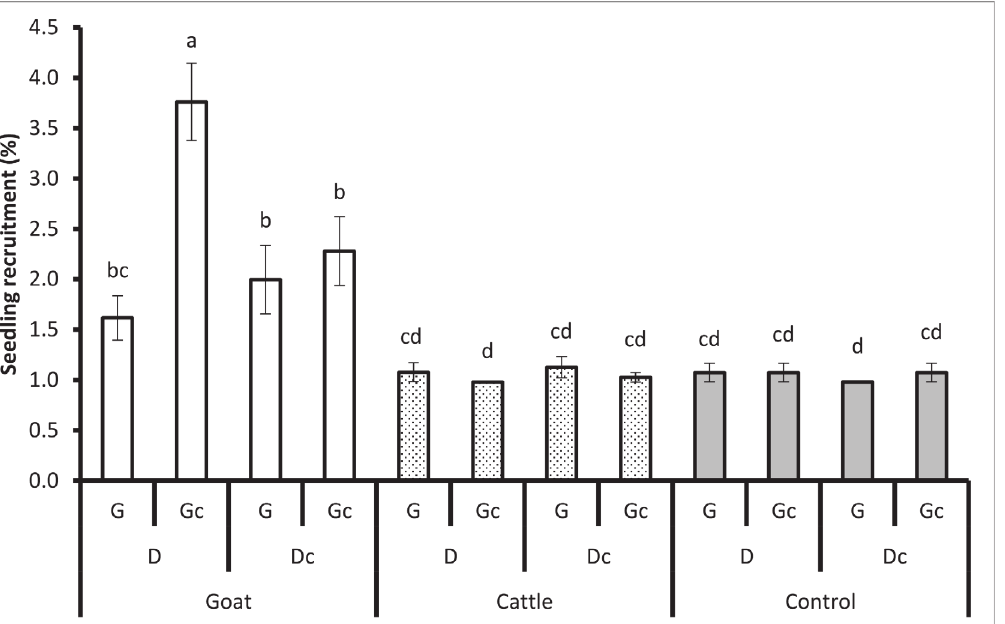
Fig 3. The treatment combination effects of animal species (goats, cattle), unpassed/untreated seeds (i.e. not ingested), dung (D) (and no dung (Dc)), and grass (G) (and mowed grass (Gc)) on seedling recruitment during the dry season. Bars represent standard errors (S.E.). Same letters on the bars mean that P > 0.05. A LSD post hoc test was used.